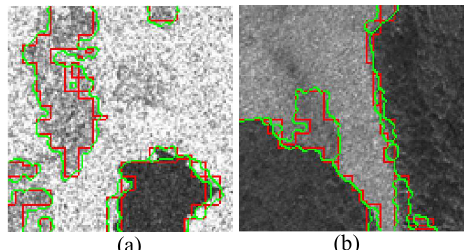
Figure 6. Visual evaluation: (a)-(c) overlaying the coarse and refined outlines on the original images.